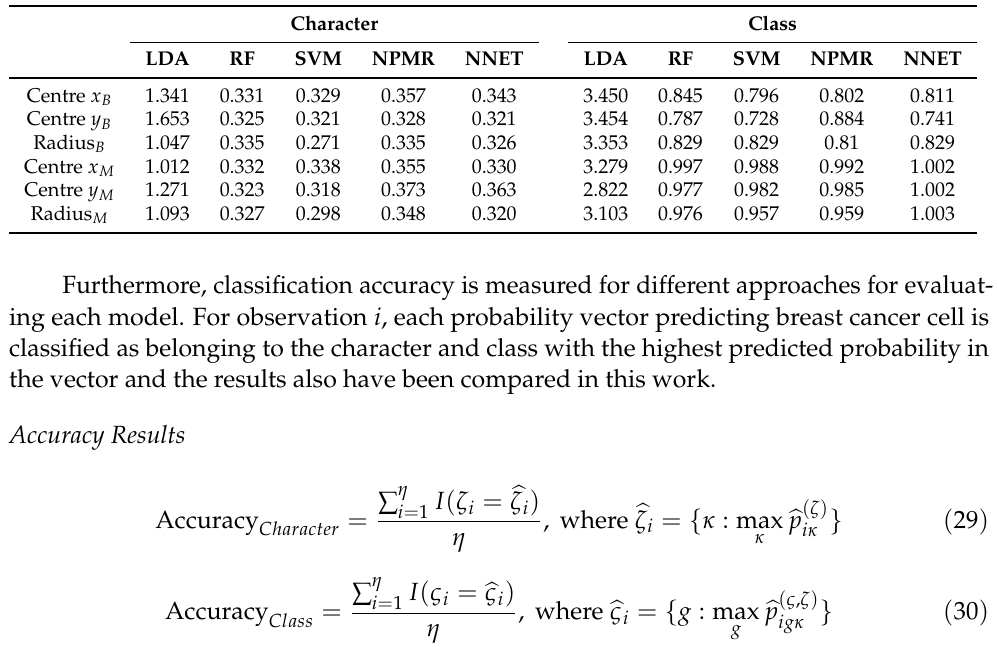
Table 1. Logloss comparison.